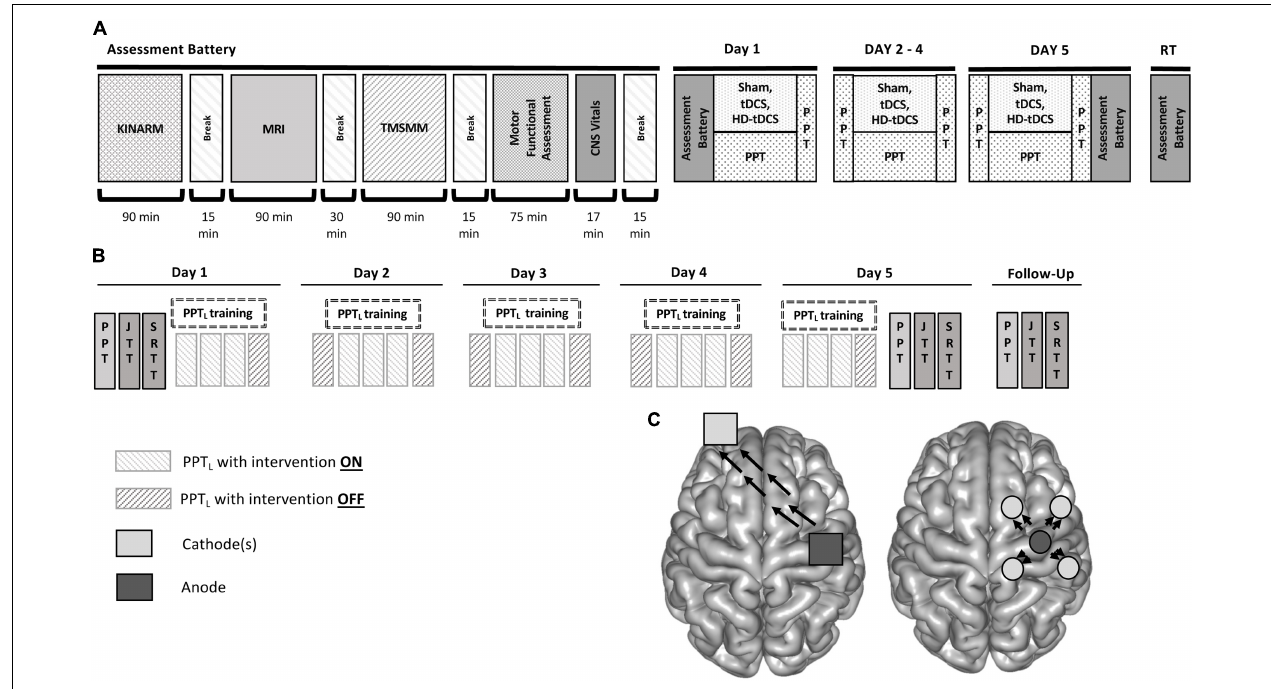
FIGURE 1 | Accelerated motor learning in pediatrics (AMPED) protocol. (A) Participants received an MRI, complete tasks in a virtual reality KINARM robotic system, received TMS motor mapping (TMSMM), completed a series of motor assessments and then received training paired with non-invasive brain stimulation interventions. On days 2–4, subjects perform the PPT during intervention. Participants repeat the Day 1 tasks on Day 5 (with training) and at a 6-weeks retention testing follow up (RT). (B) PPT training is paired with stimulation by treatment groups with electrode montages (C) shown for tDCS (left) and HD-tDCS (right) where dark gray electrodes are anodes and light gray electrodes are cathodes. Black arrows represent the direction of current flow from anode to